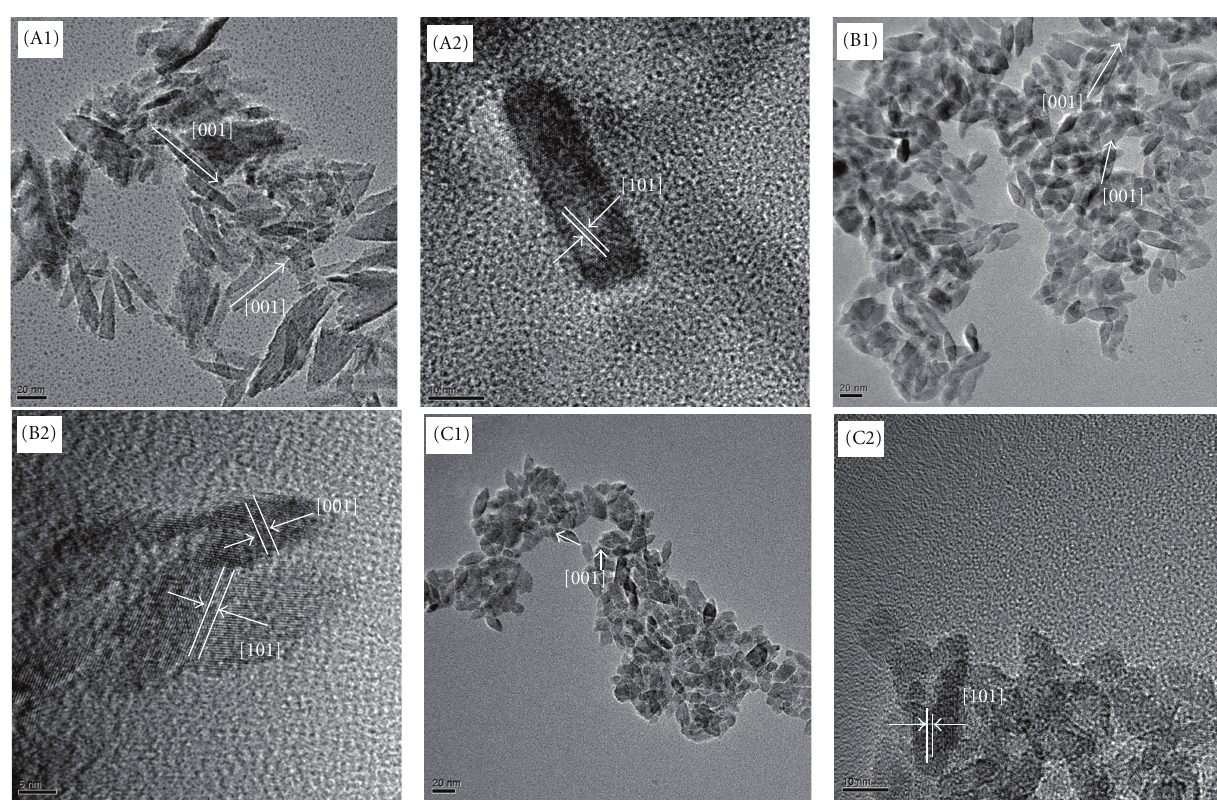
Figure 2: The TEM photos of pure TiO 2 (A) and the Fe-doped TiO 2 samples (2.0% (B) and 5.0% (C)).